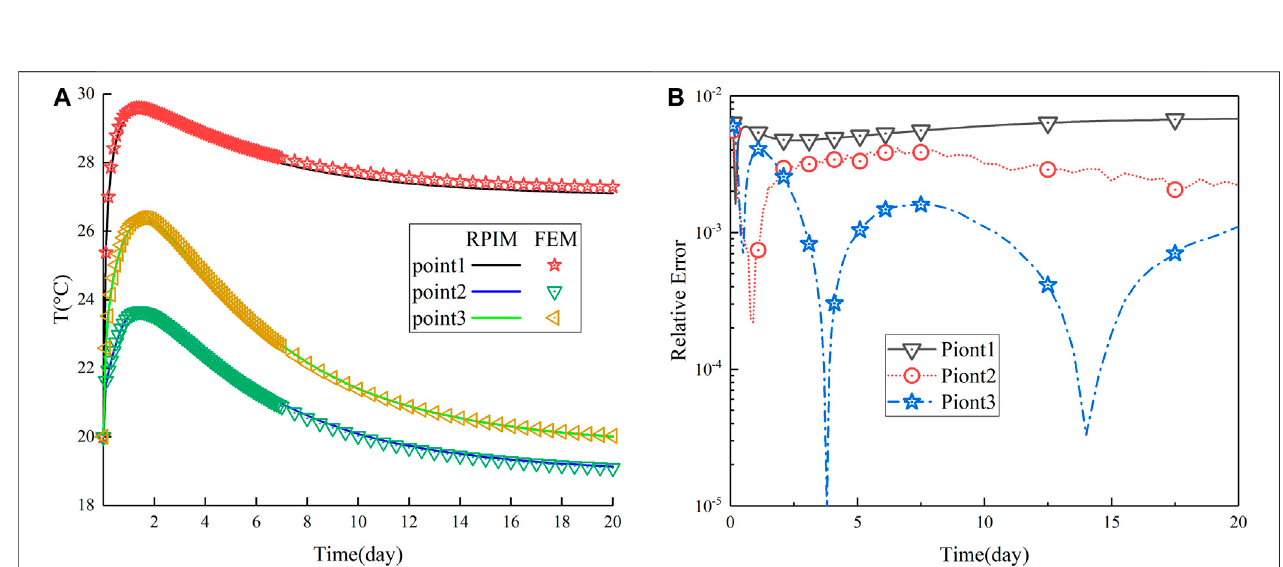
FIGURE 8 | (A) With time changed, numerical solution of FEM and RPIM at test points. (B) The RE of FEM and RPIM at the test point changes over time.